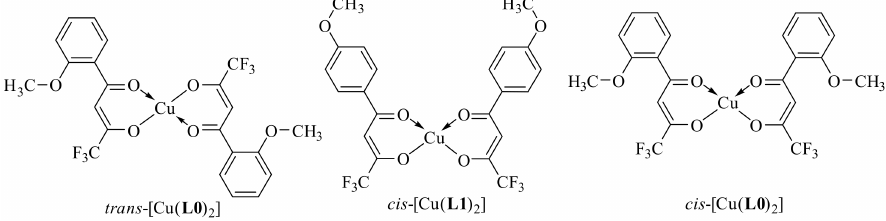
Figure 6. Structures of complexes trans -[Cu( L0 ) 2 ], cis -[Cu( L1 ) 2 ] and cis -[Cu( L0 ) 2